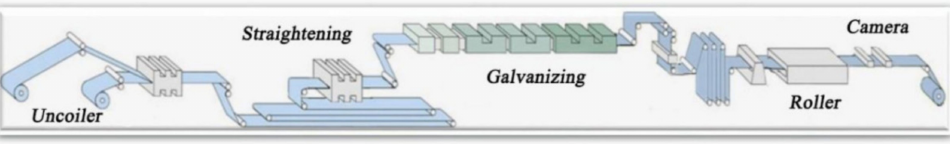
Figure 8. The flowchart of production in a real-world case.